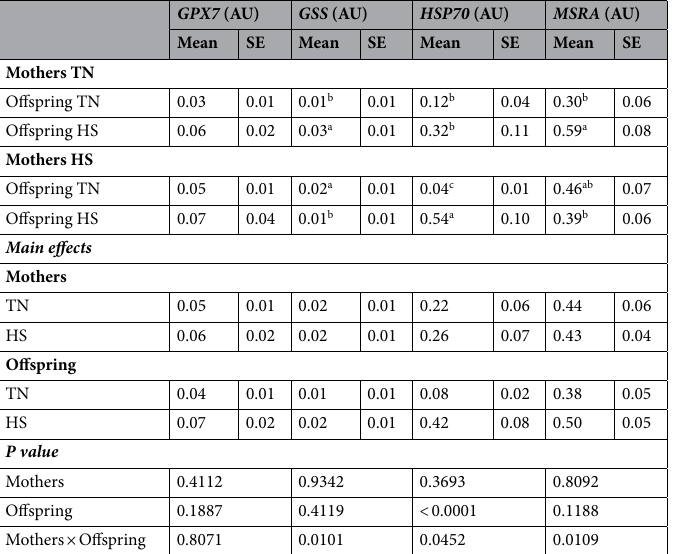
Table 5. Gene expression of Japanese quail ( Coturnix coturnix japonica ) chicks raised under thermoneutral or heat stress conditions ( n = 6). The 2 −∆CT method was used for relative quantification of gene expression, and results are expressed as arbitrary units (AU), which represent the expression of each gene normalized to the expression of β-actin mRNA. Results are presented as mean and standard error (SE). a,b,c Different superscript letters in the same column represents a significant difference by Tukey’s test ( P < 0.05).